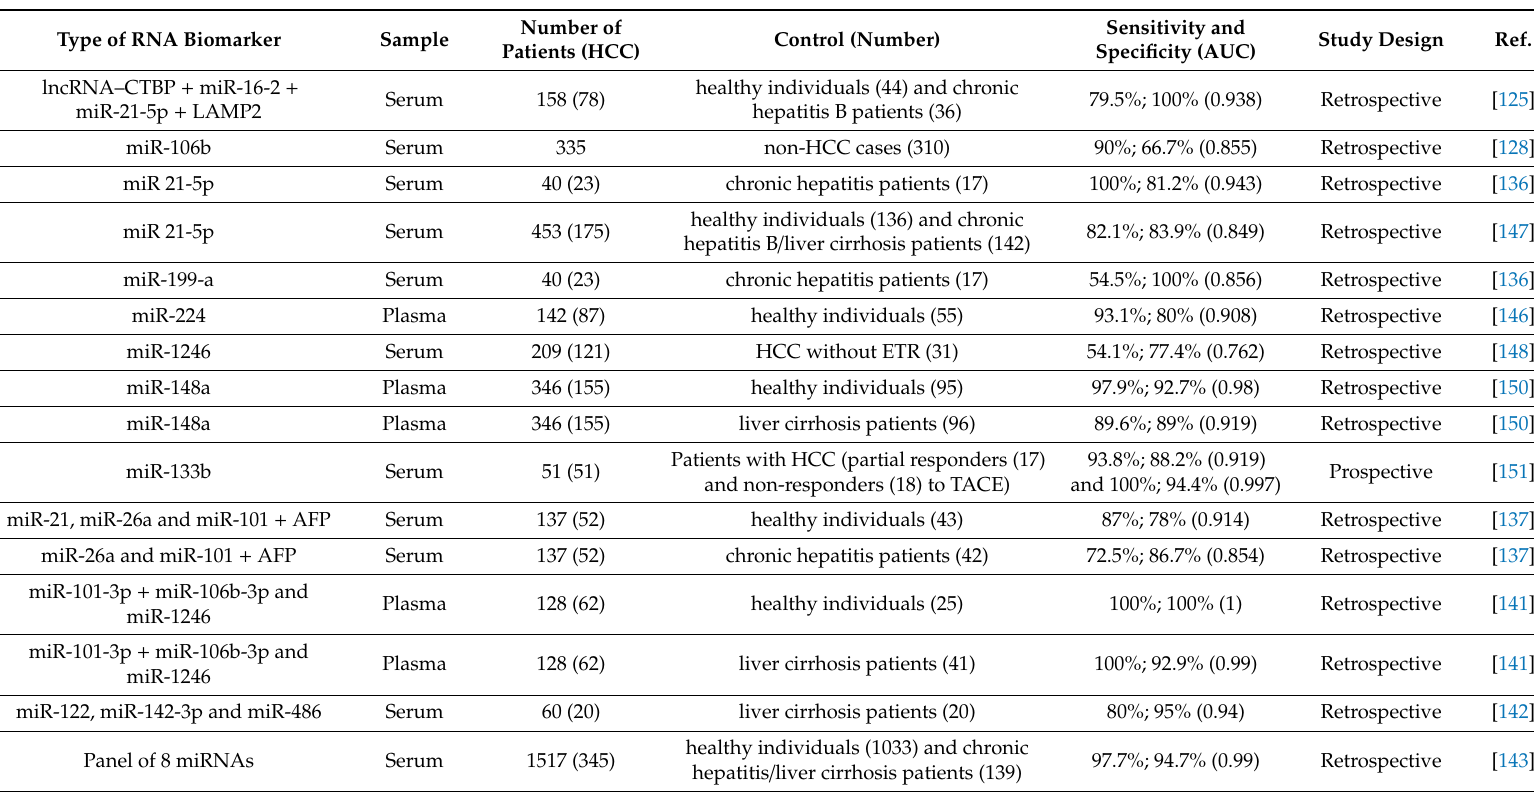
Table 3. HCC: hepatocellular carcinoma, AUC: area under the curve, lncRNA–CTBP: long non-coding RNA-C terminal binding protein, androgen responsive, LAMP2: lysosomal-associated membrane protein 2, ETR: early tumour recurrence, TACE: transcatheter arterial chemoembolization, AFP: